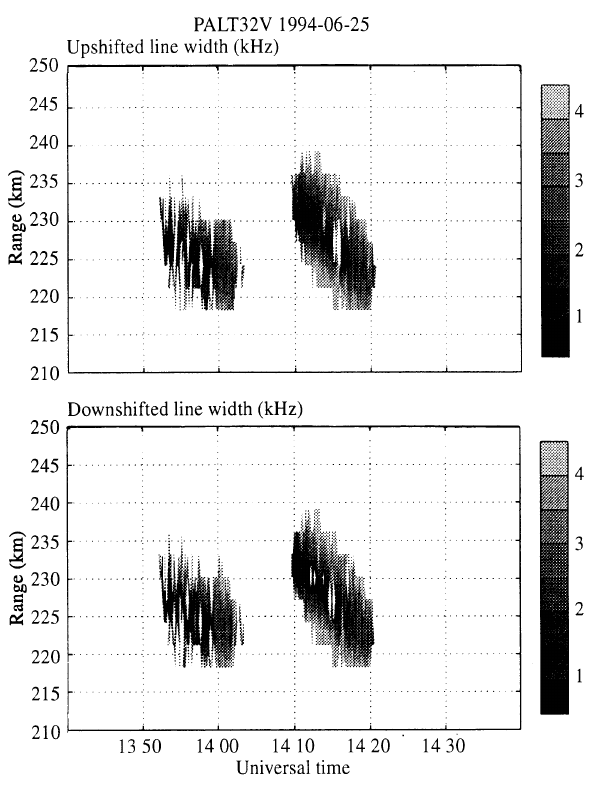
Fig. 7. The fitted upshifted and downshifted line bandwidth dis- played as a function of range and time for the